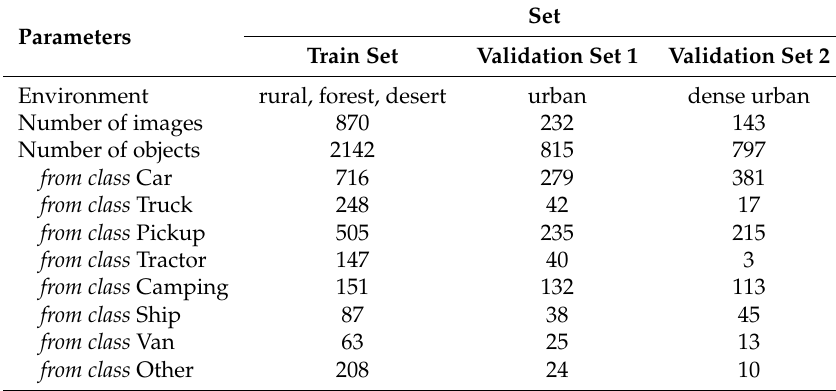
Table 9. Appearance of new backgrounds: information on the database built from VEDAI with a training set and two validation sets on two new